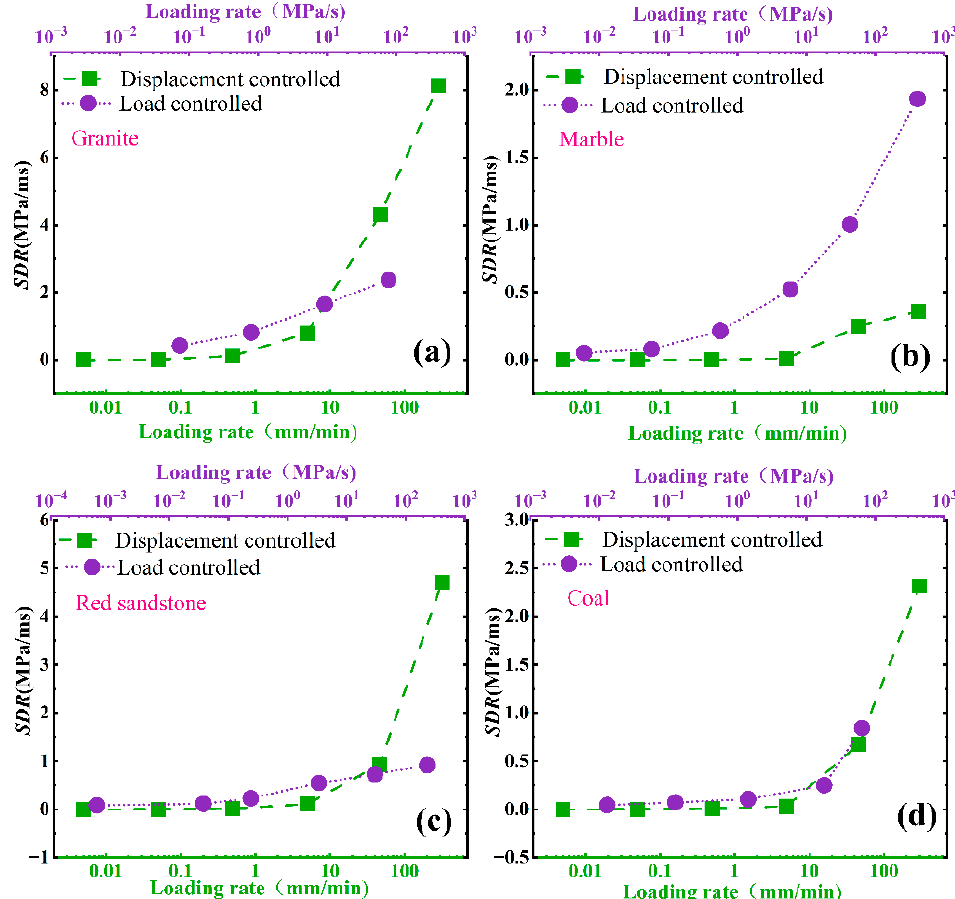
Figure 8. E ff ect of loading mode on 𝑆𝐷𝑅 : ( a ) granite, ( b ) marble, ( c ) red sandstone, ( d ) coal Figure 8. Effect of loading mode on SDR : ( a ) granite, ( b ) marble, ( c ) red sandstone, ( d )